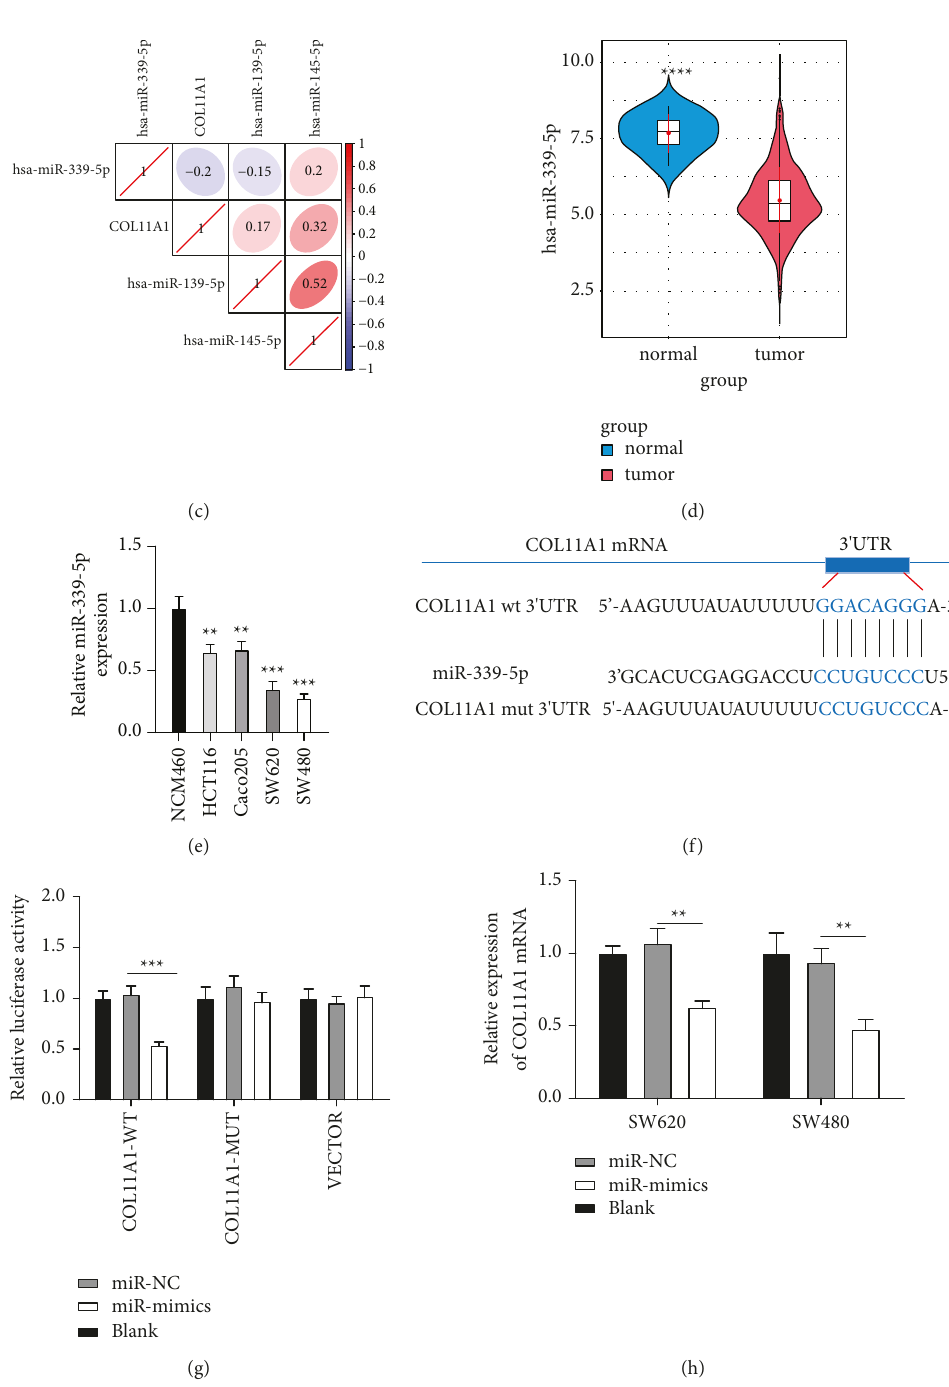
Figure 3: MiR-339-5p binds COL11A1 in colon carcinoma cells. (a) Volcano plot of differential miRNAs from TCGA-COAD. (b) Venn diagram of predicted miRNAs of COL11A1 and differential miRNAs. (c) Pearson correlation analysis of COL11A1 and its predicted upstream miRNAs. (d) Violin plot of miR-339-5p expression from TCGA database. (e) MiR-339-5p expression in NCM460, HCT116, Caco205, SW620, and SW480 cell lines. (f) Bioinformatics predicted binding sites of miR-339-5p and COL11A1. (g) Relative luciferase activity of different transfection group. (h) COL11A1 mRNA expression level in colon carcinoma SW620 and SW480 after overexpressing miR-339-5p. ∗ p < 0 . 05, ∗∗ p < 0 . 01, ∗∗∗ p < 0 .